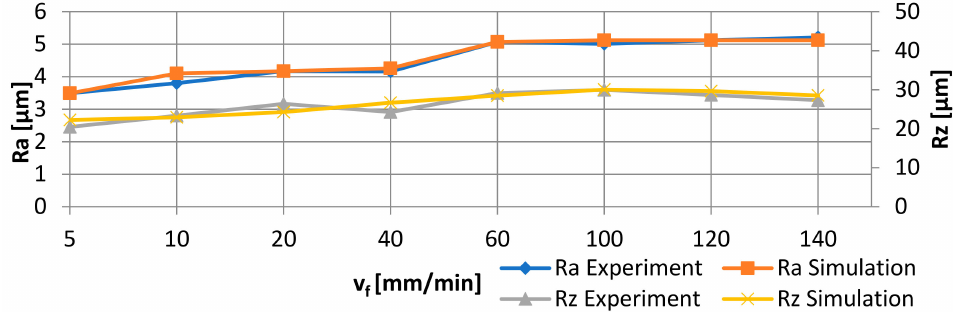
Figure 14. Comparison of experimental and numerical results depending on the jet feed velocity v f for abrasive flow rate m a = 50% and MLP 2-8-1 (Ra and